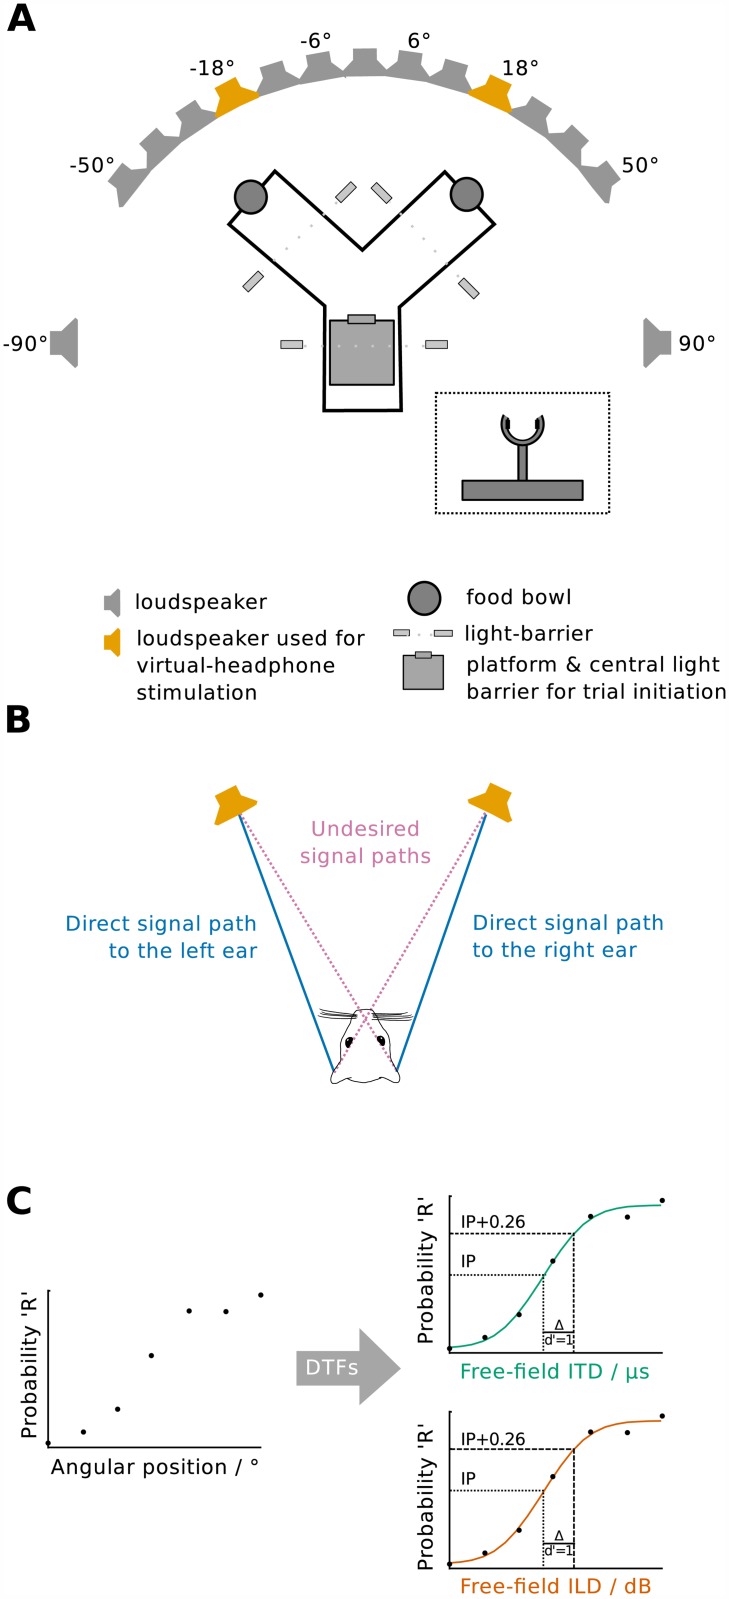
Methods and procedures.(A) Schematic of the experimental setup. Free-field stimuli were presented from a subset of an array of 15 loudspeakers distributed between -90° and 90° (gray and orange). Virtual-headphone stimuli were presented from the loudspeakers positioned at ±18° (orange). Animals moved on a Y-shaped platform and initiated trials by disrupting a light-barrier in a half-ring-shaped poke-hole (inset) with their nose. Animals' movements and responses were monitored by further light-barriers. Correct responses were rewarded by dispensing food rewards into food bowls from dispensers (not shown) fixed on the ceiling of the sound-attenuated booth. (B) Sketch illustrating the generation of virtual-headphone stimuli using cross-talk cancellation. The undesired signal paths (pink) between the loudspeakers and the respective contralateral ears are eliminated by destructive interference in the ears resulting in only the direct signal paths (blue) remaining present at the ears. (C) The free-field performance measured as probability of an approach to the right was transformed to free-field interaural level difference (ILD) and free-field interaural time difference (ITD) performance by extracting ITD and ILD values from the directional transfer functions (DTFs) obtained for the angular positions tested. Thresholds were then calculated by fitting a cumulative normal distribution function (green and red lines) to the raw data (circles) and determining the difference in ITD or ILD at the inflection point of the function (IP, dotted line) and 0.26 above the inflection point (IP+0.26, dashed line), thus corresponding to a d’-value of 1.